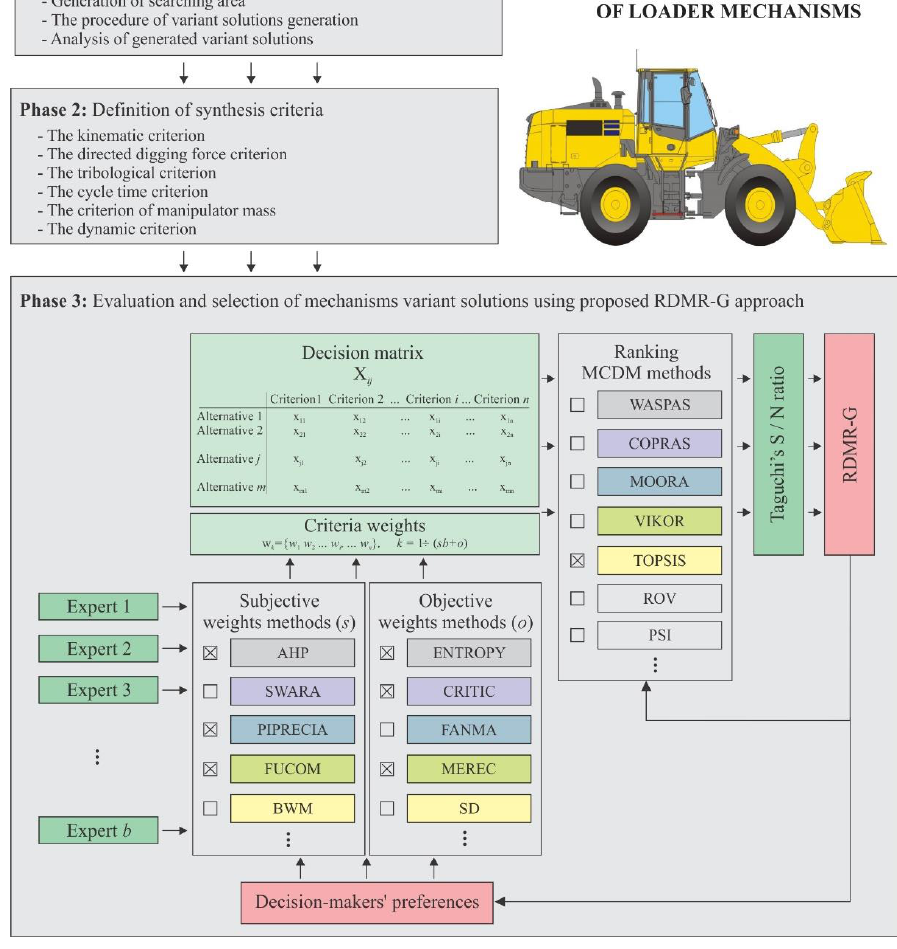
Figure 3. Schematic three phase algorithm for the optimal synthesis of loader mechanisms.